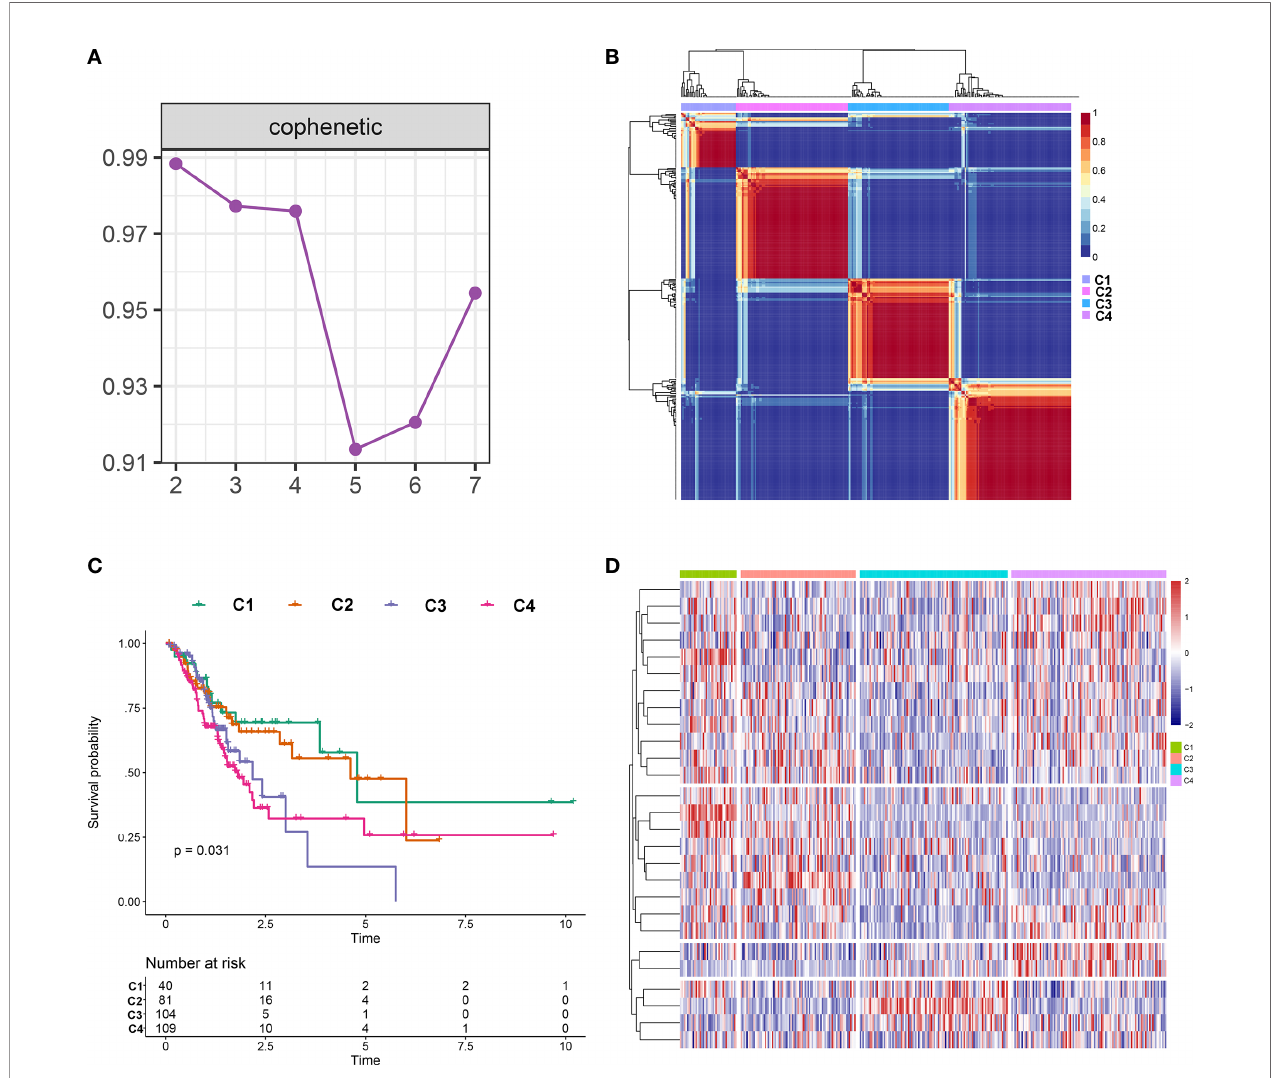
FIGURE 12 | Identi fi cation of molecular subtypes in the complete dataset. (A) Cophenetic correlation coef fi cient analysis for k = 2 to k =7. (B) Consensus heatmap for the gene expression when k = 4. (C) Kaplan-Meier survival curves for the cluster when k =4. (D) A heatmap for the four molecular subtypes in the GC